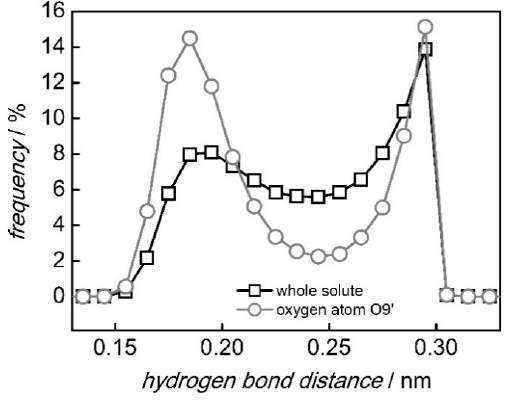
Figure 5. Distribution of distances between tetramethyl 1,4-diol and TIP4P water for the whole solute (black squares) and oxygen atom O9 ′ (grey circles).